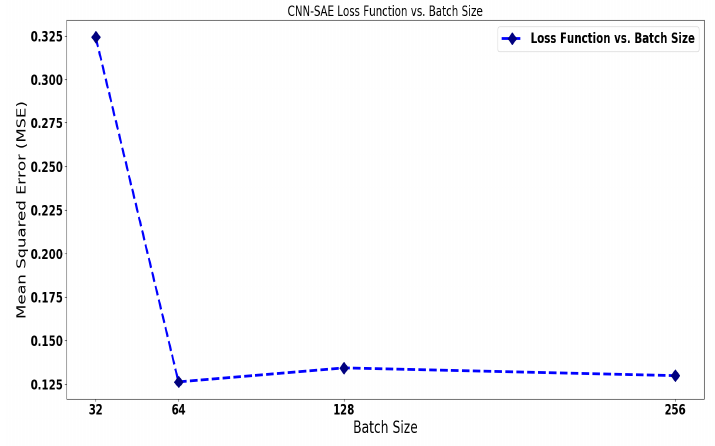
Figure 7. CNN-SAE: Loss Function vs. Batch Size: The lowest MSE Loss function value on the validation set (0.0126) is achieved when we set the batch size value into